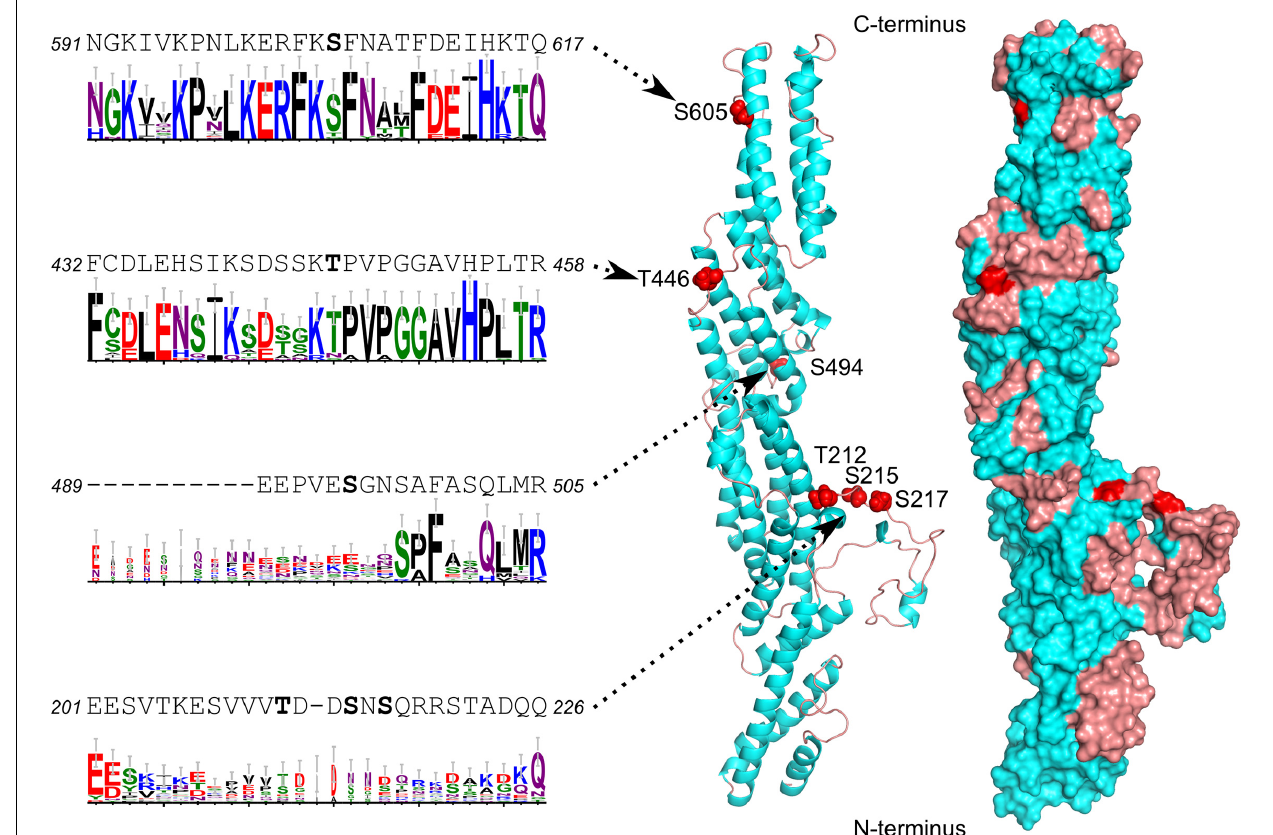
FIGURE 2 | Homology model of Arabidopsis EXO70C2 showing the positions of studied phosphosites, their adjacent sequences and sequence logos illustrating the evolutionary conservation within dicots. The structure is shown as ribbon and surface representation with alpha-helices in cyan, loops in brown and phosphosites in red. See Supplementary Figure S1 for the full alignment and additional